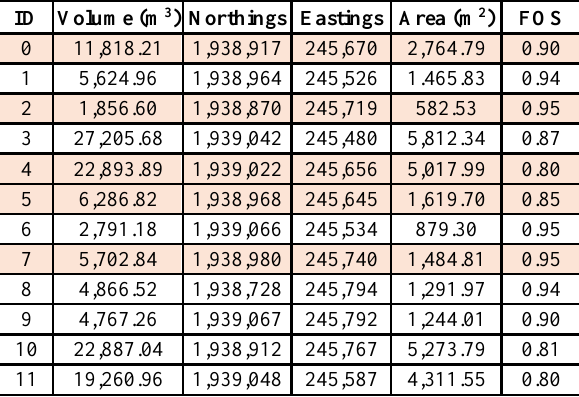
Table 3. Potential Volume.